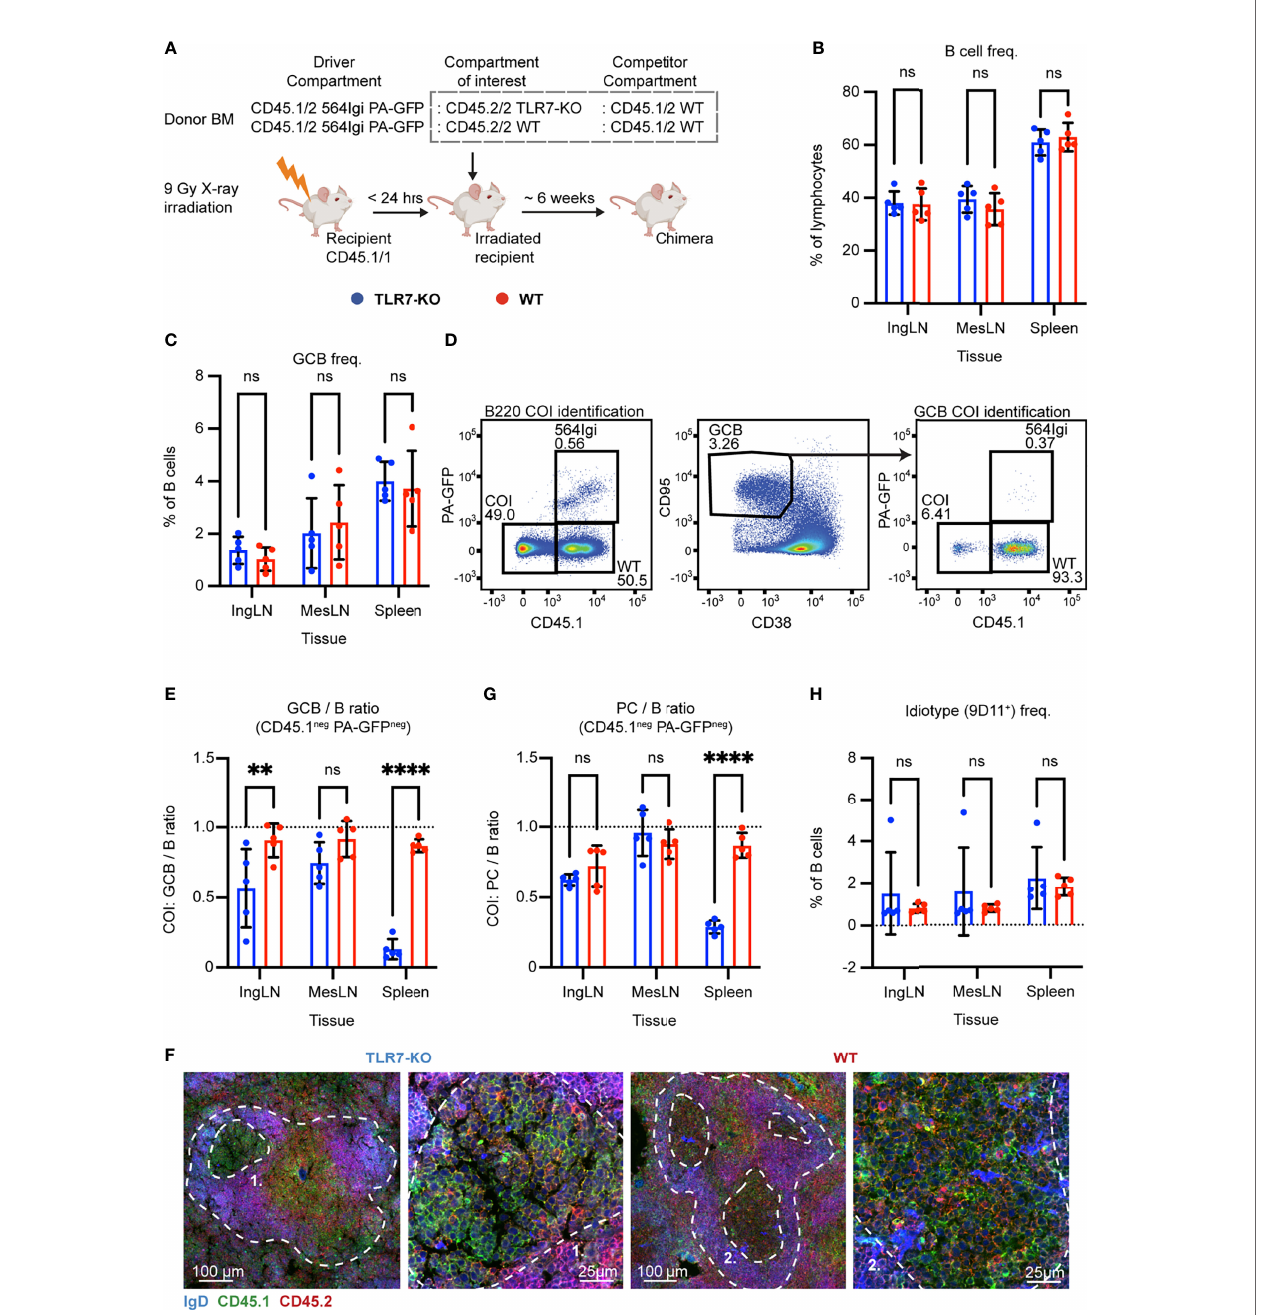
FIGURE 4 | B cell intrinsic TLR7 signaling is critical for autoreactive germinal center participation. (A) Schematic overview of experimental setup with timeline. (B) B cell frequencies out of live, singlet lymphocytes, in lymphoid tissues of TLR7-KO (blue, n = 5) and WT (red, n = 5) chimeras. Each dot represents an individual mouse and bars indicate mean +/- SD, with statistical signi fi cance given for two-way ANOVA followed by Sidak ’ s post-test ( a = 0.05), ns = not signi fi cant, ** = p<0.01, **** = p<0.0001. (C) As in (B) , but for GCB cell frequencies instead. (D) Representative example from a TLR7-KO chimera showing gates used to de fi ne CD45.1 vs. PA-GFP within the B cell (left) and GCB cell (right) compartments, and the parent GCB cell gate (center). (E) As (B) but showing relative GCB to B cell ratios for the compartment of interest (COI, CD45.1 - PA-GFP - ). (F) Confocal micrographs of spleen sections from a representative TLR7-KO chimera and WT control chimera stained for IgD (naïve B cells, blue), CD45.1 (green), CD45.2 (red) and the marginal zone (CD169, not shown). Left two panels originate from a TLR7-KO chimera, lower magni fi cation image with indication of the marginal zone (broken white line, based on CD169 staining, Figure S4J ) and a GC (numbered), followed by higher magni fi cation image of that GC. Right two panels, like those on the left but originating from a WT chimera instead. Channel assignments and brightness were adjusted to enhance visual clarity of micrographs. (G) As (E) but showing relative PC (plasma blast/cell, CD138 hi within live, singlet lymphocytes) to B cell ratios for the compartment of interest (COI, CD45.1 - PA-GFP - ). (H) As (B) , but for 564Igi idiotype (9D11 + ) frequencies of B